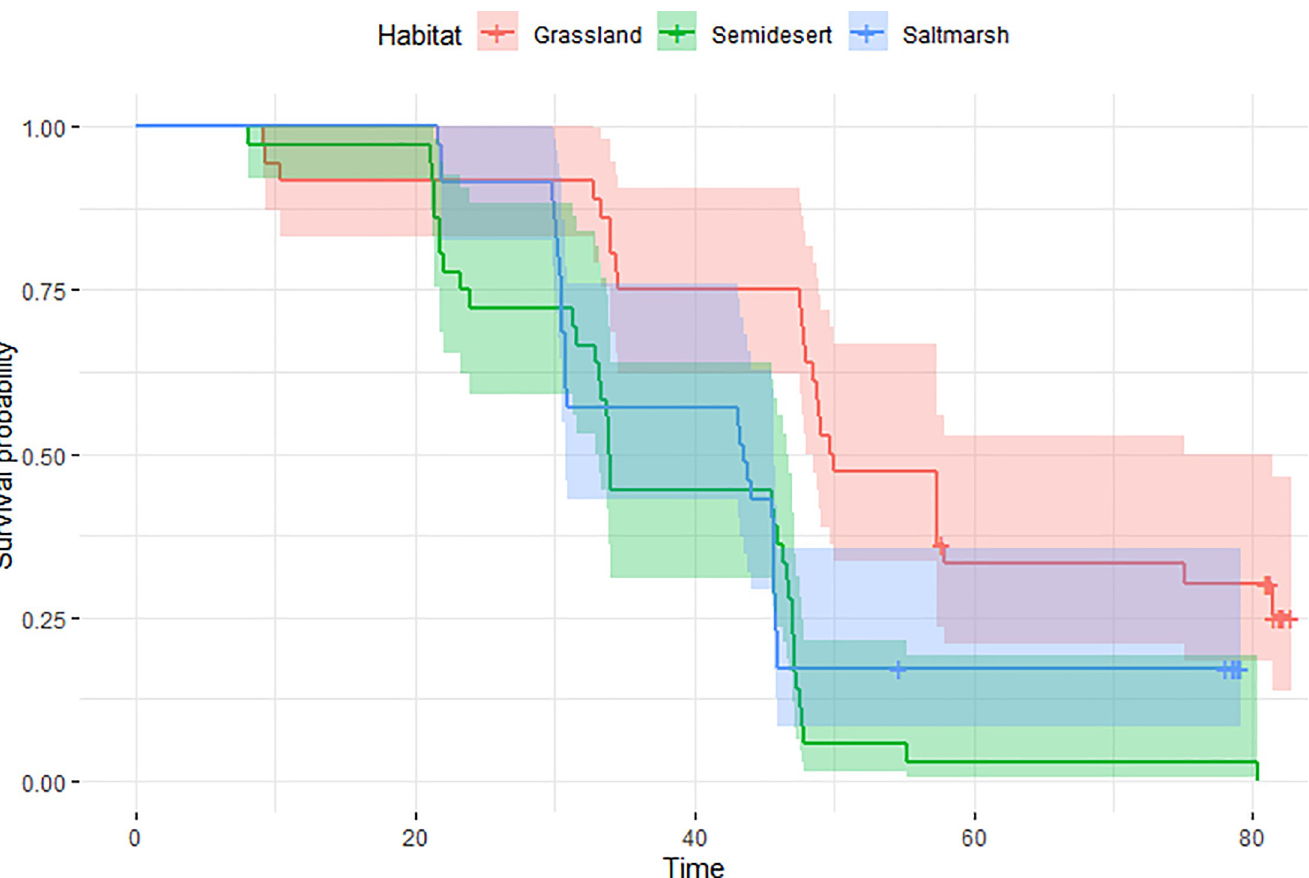
Fig 3. Nest survival in relation to habitats: Grassland (N = 36) 95% CI (48.0–75.1), Saltmarsh (N = 36), 95% CI (33.0–46.7) and Semidesert (N = 35), 95% CI (30.8–45.8). Total number of nests: N = 107.